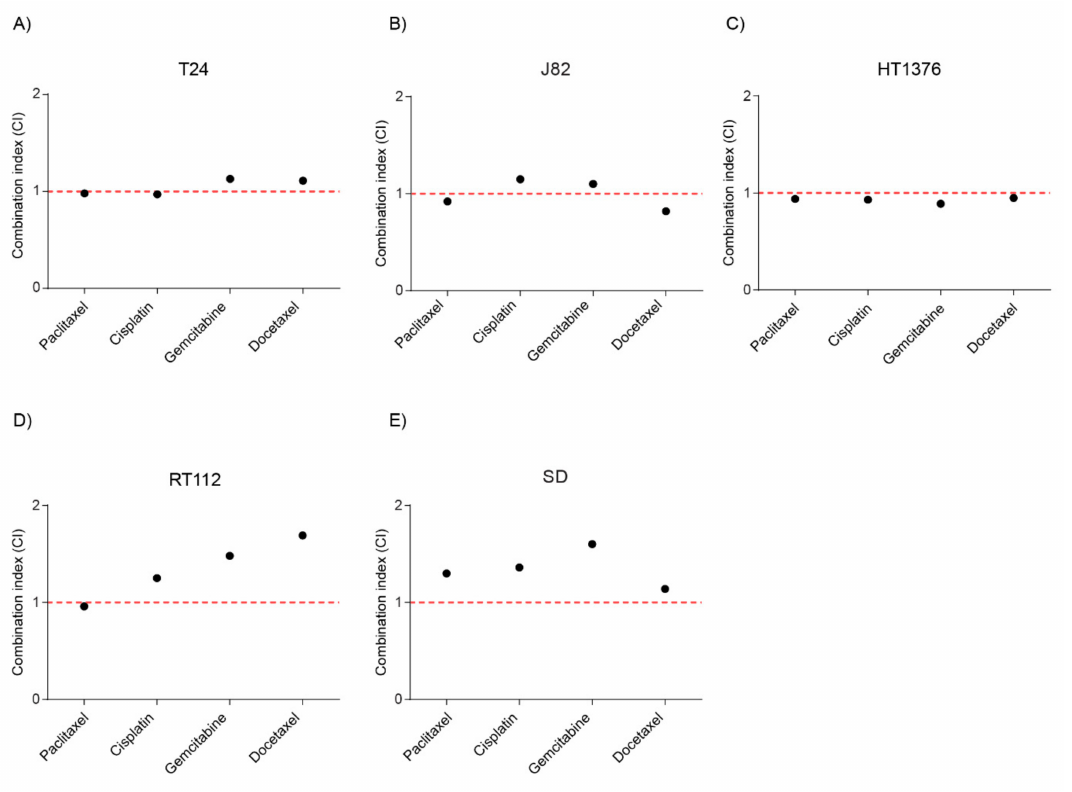
Figure 4. Combination therapy with Stattic and chemotherapeutics. Treatment of the respective cell lines was done for 72 h with Stattic alone and in a fixed ratio combination with Paclitaxel, Cisplatin, Gemcitabine or Docetaxel in ( A ) T24, ( B ) J82, ( C ) HT1376, ( D ) RT112, and ( E ) SD cell lines (See Materials and methods). Combination index (CI) for combining Stattic with Paclitaxel, Cisplatin, Gemcitabine or Docetaxel were plotted. Values were calculated using the Chou-Talalay theorem. CI < 1: synergy, CI = 1; additivity, CI > 1: